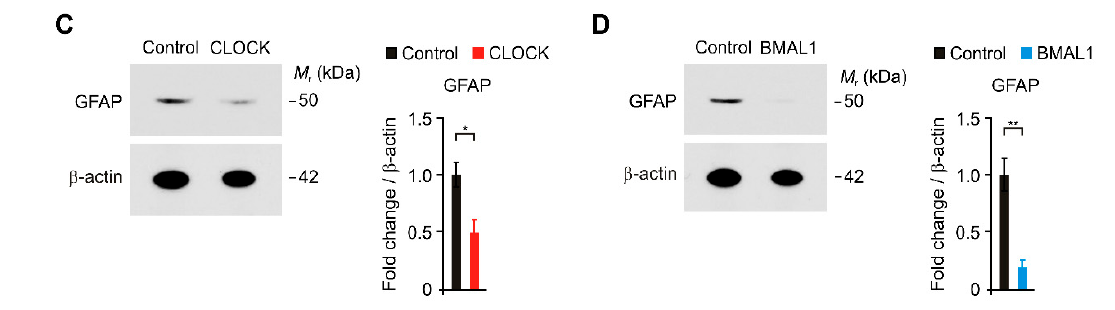
Figure 3. The elevation of CLOCK and BMAL1 contributes to the functional impairment by reduction in GFAP-positive filaments in human astrocytes. ( A ) Representative immunofluorescence images of CLOCK expression in control and CLOCK-overexpressing (CLOCK) human astrocytes showing CLOCK (green) and GFAP (red) ( n = 10 per group). DAPI-stained nuclei are shown in blue. The shortness and shrinkage of GFAP-positive filaments were indicated (white arrows). Scale bars, 20 μ m. ( B ) Representative immunofluorescence images of BMAL1 expression in control and BMAL1-overexpressing (BMAL1) human astrocytes showing BMAL1 (green) and GFAP (red) ( n = 10 per group). DAPI-stained nuclei are shown in blue. The shortness and shrinkage of GFAP-positive filaments were indicated (white arrows). Scale bars, 20 µ m. ( C ) Representative immunoblot analysis for GFAP (left) and quantification for GFAP protein levels (right) in control and CLOCK-overexpressing (CLOCK) human astrocytes. For immunoblots, β -actin was used as loading control. Data are representative of three independent experiments. Data are mean ± SEM. * p < 0.05 using the two-tailed Student’s t -test. ( D ) Representative immunoblot analysis for GFAP (left) and quantification for GFAP protein levels (right) in control and BMAL1-overexpressing (BMAL1) human astrocytes. For immunoblots, β -actin was used as loading control. Data are representative of three independent experiments. Data are mean ± SEM. * p < 0.05, ** p < 0.01 using the two-tailed Student’s t